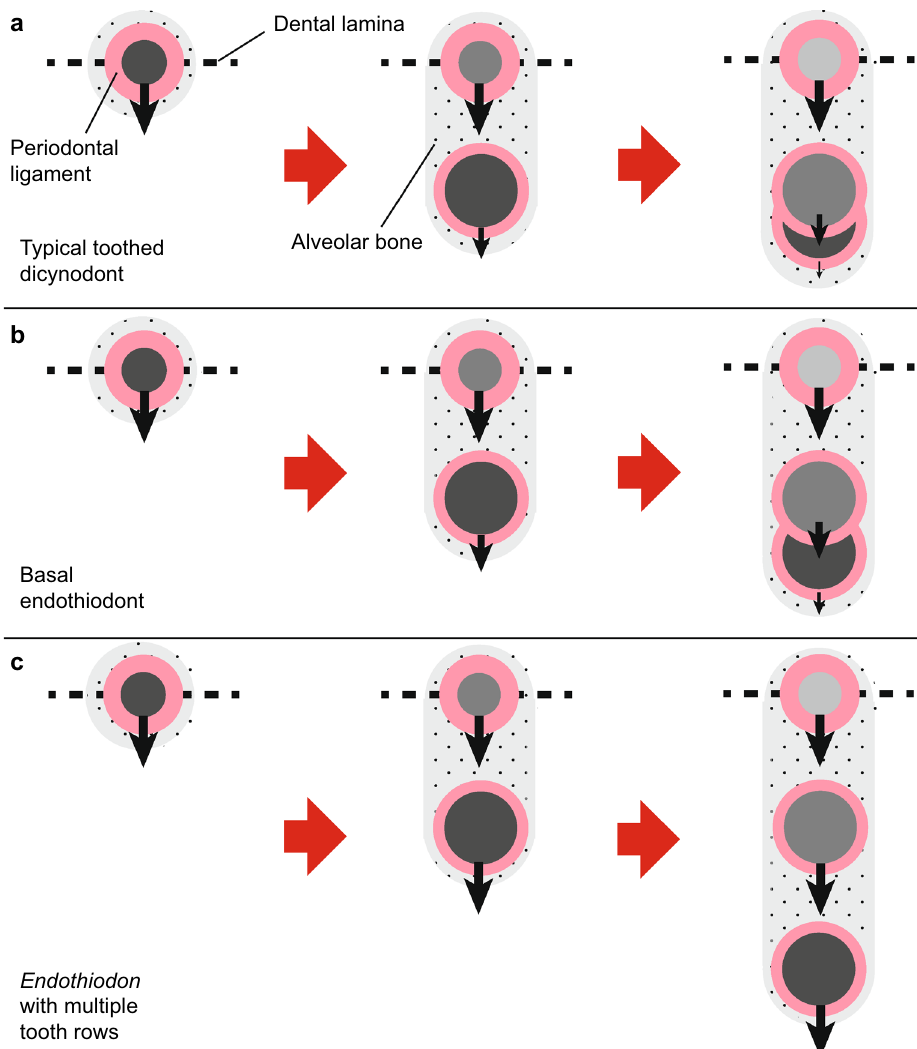
Figure 12. Model of multiple tooth row development in Endothiodon bathystoma . ( a ) Typical tooth replacement in a stemward dicynodont, in which the migration of functional teeth and their sockets (black arrows) slows over time, allowing replacement by newer teeth. ( b ) Tooth replacement in stemward endothiodonts, in which faster migration of functional teeth causes incomplete tooth replacement to happen more frequently, leaving behind tooth remnants. ( c ) Tooth emplacement in Endothiodon with multiple tooth rows, in which functional teeth and sockets maintain a rapid migration pace, allowing them to avoid